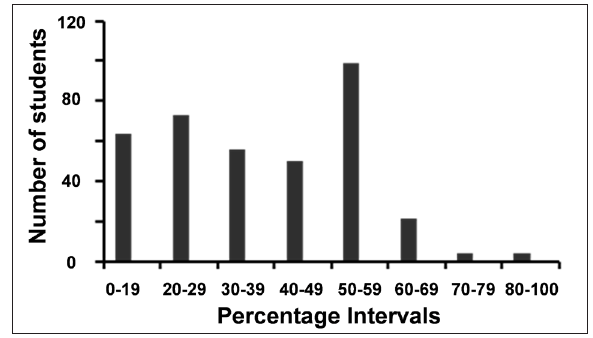
Figure 1: Performance of students in the University Preparation Pro- gramme in the first-year Mathematics module (WIS104) over the period 1994–2004.